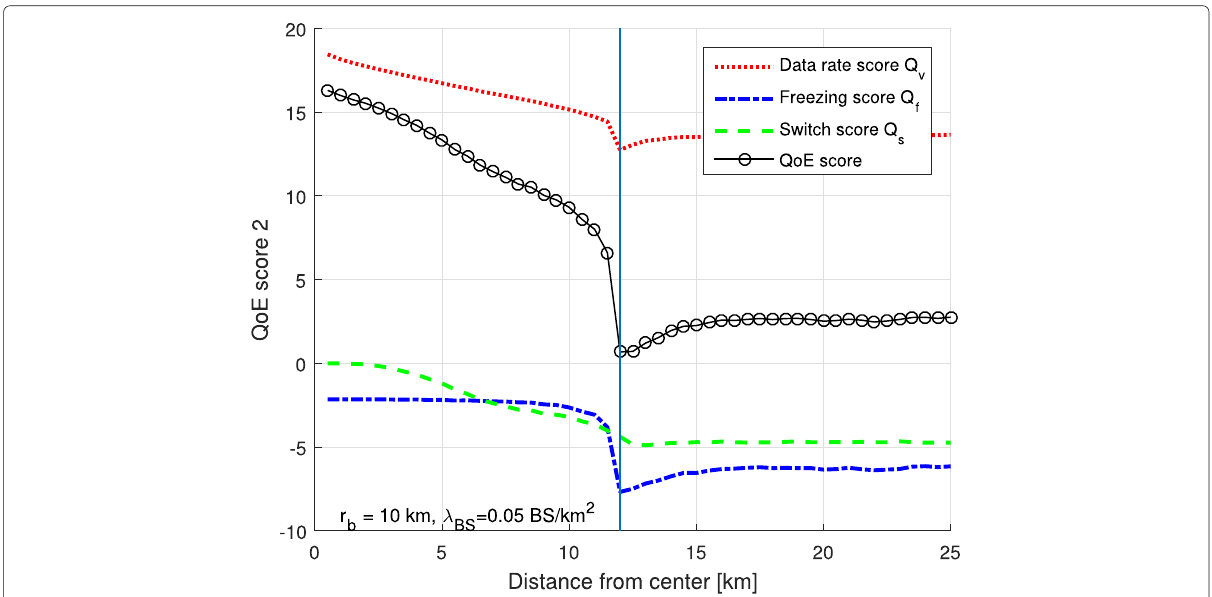
Fig. 15 The QoE versus the relative position from the center of the service area for